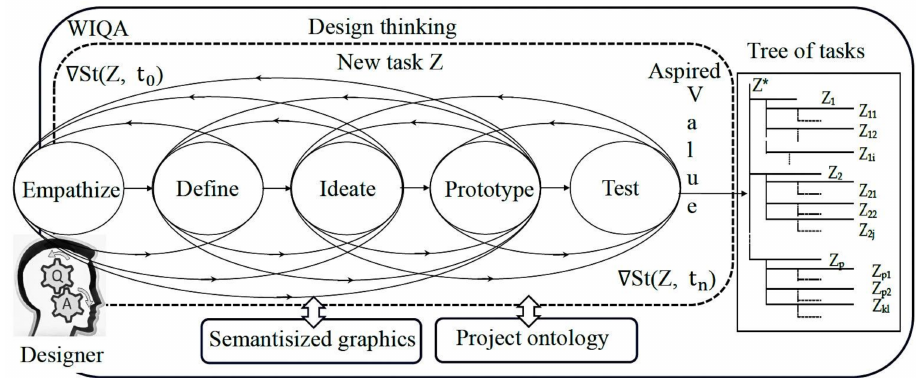
Figure 16. The iterative process of design